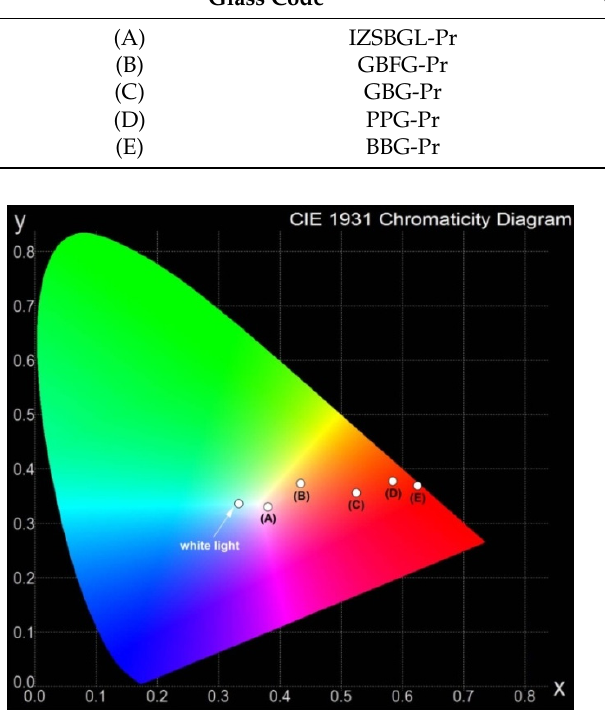
Table 5. CIE chromaticity coordinates for the studied inorganic glasses doped with Pr 3+ . Glass Code CIE Chromaticity Coordinates